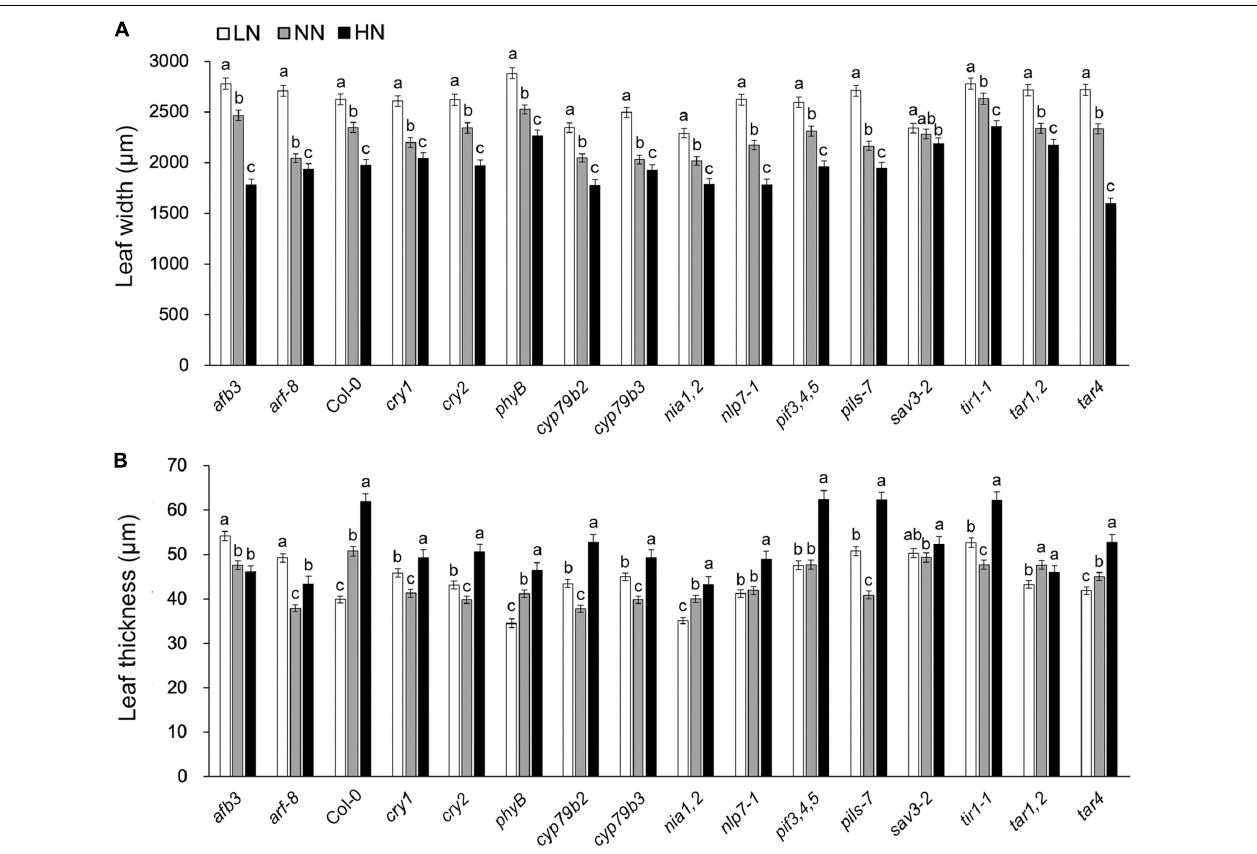
FIGURE 1 | Changes in leaf width/thickness under different N levels were compromised in sav3 mutant. A total of 15 auxin-related or nitrogen-signal-related Arabidopsis mutants were enrolled. Maximum widths (A) and average thicknesses (B) of 14-day-old leaves grown under different N levels were determined. LN, low N condition; NN, normal N condition; HN, high N condition. Bars represent standard deviations of 15 independent replicates. Values of each plant material followed by different letters are significantly different at P < 0.05 according to Duncan’s multiple range